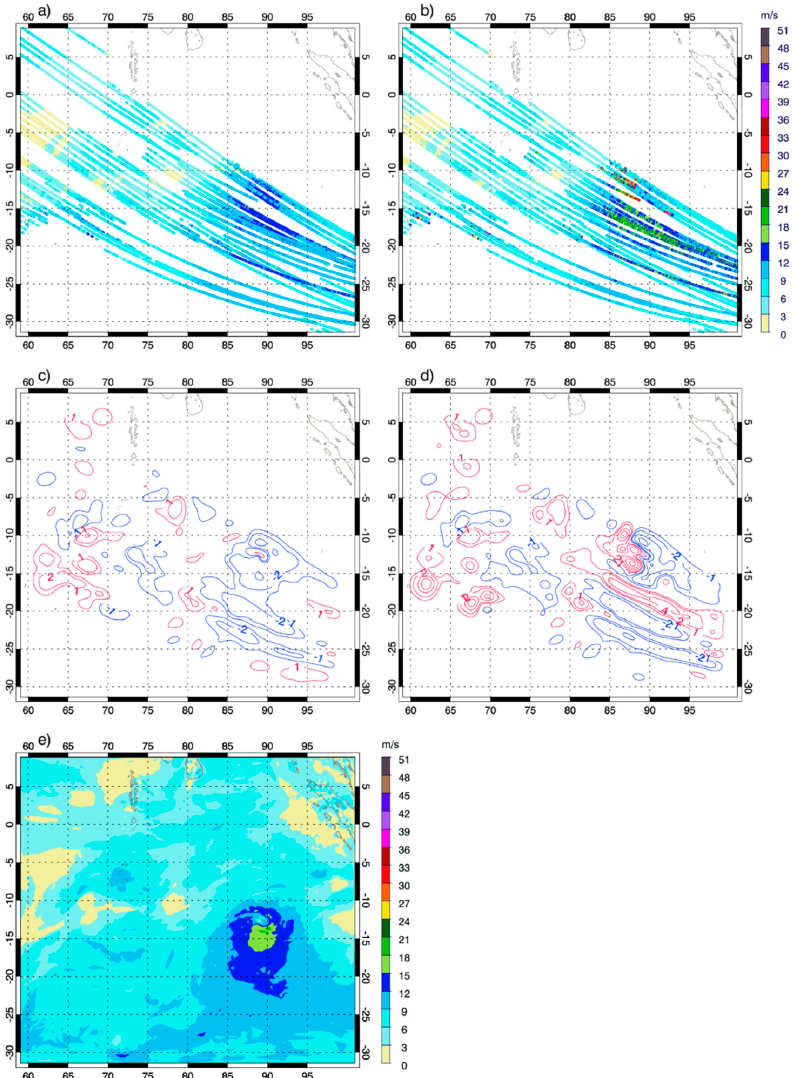
Figure 4. CYGNSS wind speed observation ( a ) FDS and ( b ) YSLF. The analysis increments from ( c ) DA_cyg_fd and ( d ) DA_cyg_lf. The blue contours represent negative values and red contours represent positive values. The contour interval is 1 m s − 1 . ( e ) wind field in background WRF simulation. All plots are at 1500 UTC on 6 January 2018.